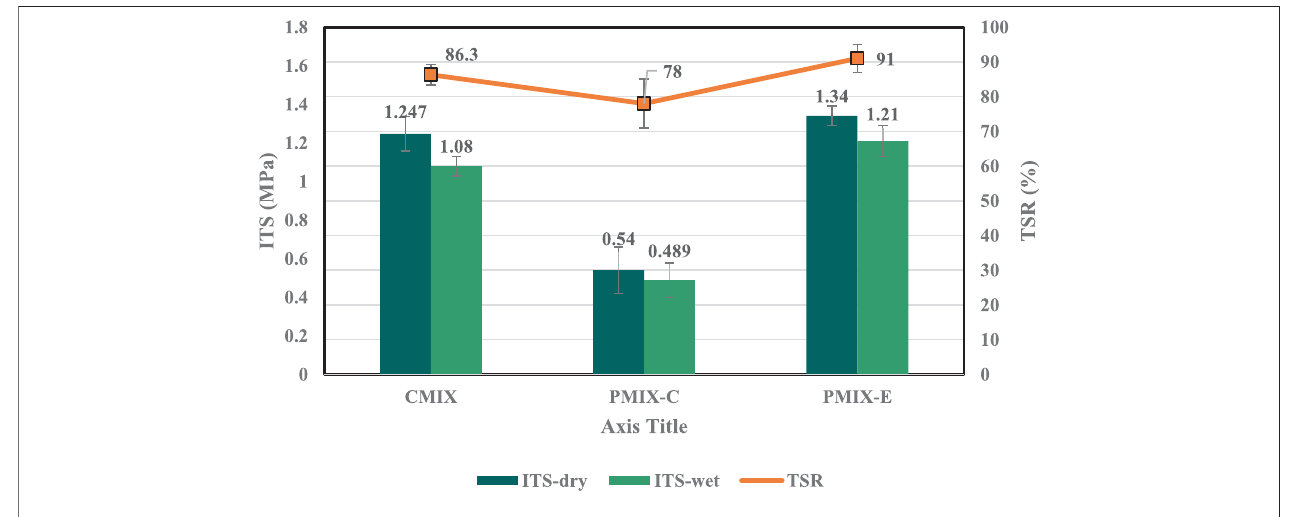
FIGURE 7 | TSR and tensile strength value of the control and PMIX-E